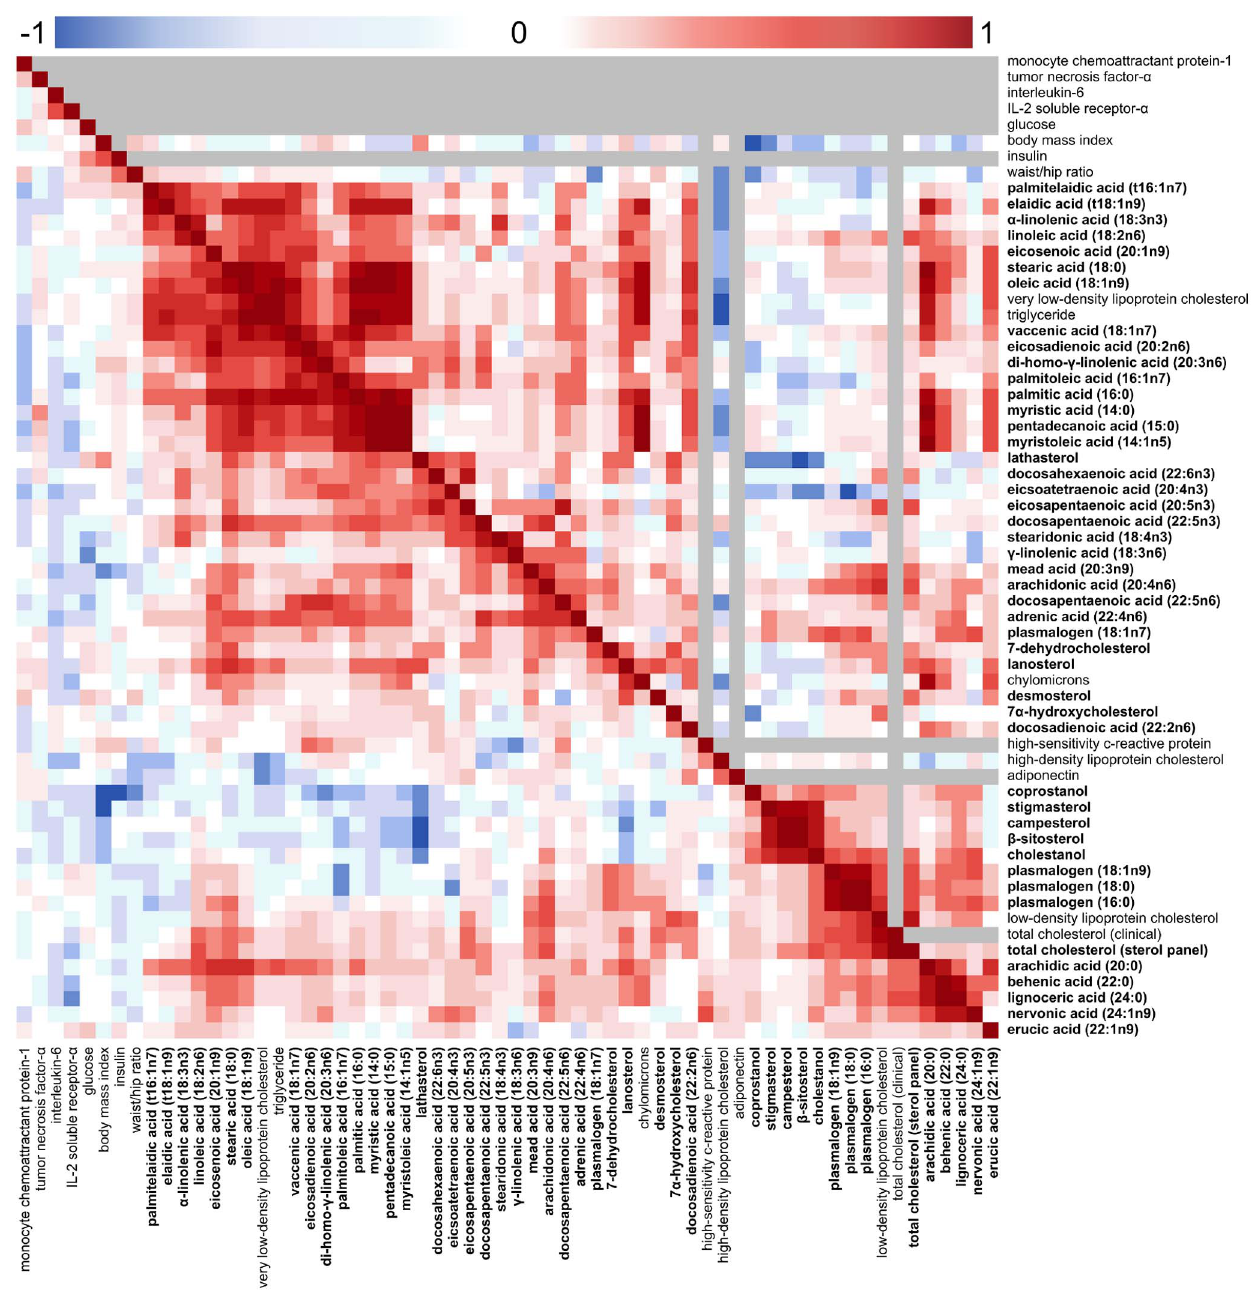
Figure 1. Data from 40 Genetics of Lipid Lowering Drugs and Diet Network Study participants. 1a (below the diagonal)-Pairwise correlation of fasting sterols (bold), fatty acids (bold), clinical lipids, inflammatory markers, and other clinical measures. 1b (above the diagonal)- Pairwise correlation of change in postprandial sterols (bold), fatty acids (bold), clinical lipids, and other clinical measures. Grey lines indicate clinical parameters not captured